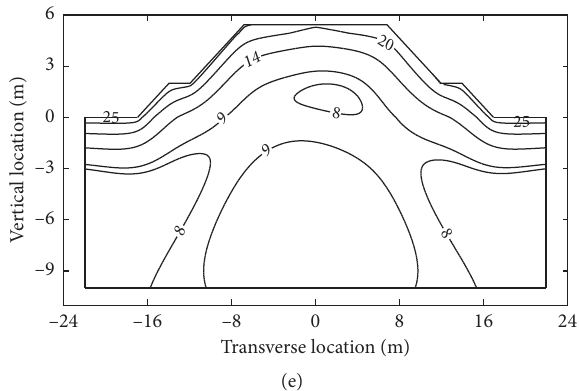
Figure 5: Temperature field distribution of the section at a typical moment ( ° C). Temperature field distribution on (a) August 01, 2013, (b) December 10, 2013, (c) March 10, 2014, (d) April 10, 2014, and (e) August 01, 2014.